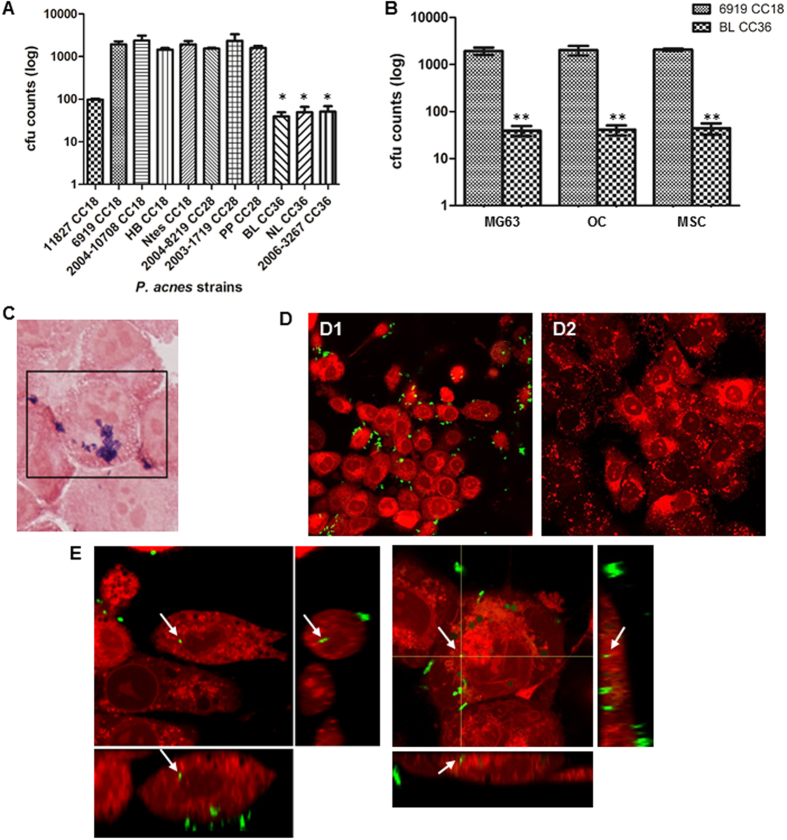
Host cell type-specific internalization of Cutibacterium acnes.(A) MG-63 cells were infected with different C. acnes strains at a MOI of 100:1 for 2 hours. After 2 h, cells were washed, treated with penicillin/streptomycin, washed again and lysed. CFU counts were determined after 5 days of anaerobic culture of the lysate on Schaedler plates. *P < 0.01. (B) MG-63 cells, osteoclasts (OC) and mesenchymal stem cells (MSC) were infected with different C. acnes strain at a MOI of 100:1 for 2 hours. After 2 h, cells were washed, treated with penicillin/streptomycin, washed again and lysed. CFU counts were determined after 5 days of anaerobic culture of the lysate on Schaedler plates. **P < 0.01. (C) MG-63 cells Gram stained (ATCC6919 C. acnes cells appear in purple). (D) Live confocal microscopy pictures after 2 h of incubation with MG-63 cells and washing. MG-63 cell membranes were stained with calcein red/orange (red). C. acnes bacteria were stained with fluorescein isothiocyanate (green). D1. Result with C. acnes ATCC6919 strain. D2. Result with C. acnes BL isolate. (E) Orthogonal views from different planes (x/y, x/z or y/z) of the live confocal microscopy images used to analyze the ATCC6919 CC18 C. acnes location. Bacteria (FITC, green) inside the cell (cellular membranes, stained with calcein red/orange, appear in red) are indicated by a white arrow.